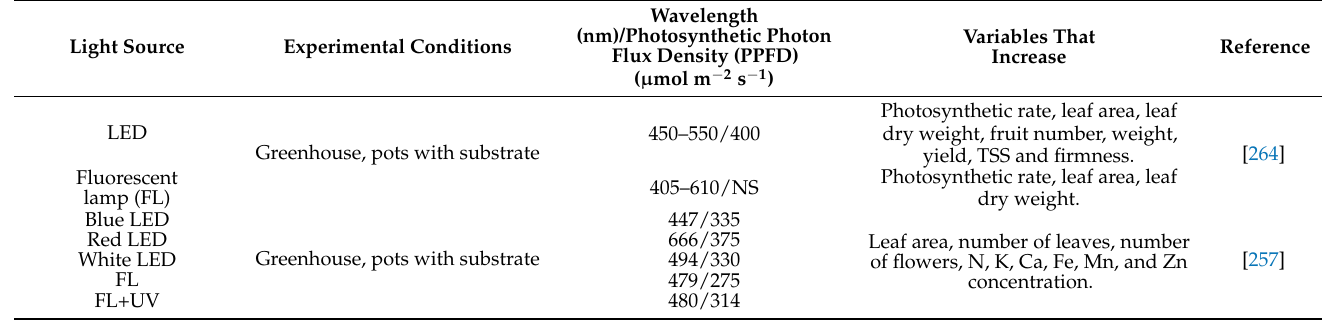
Table 11. Positive effects of UV and visible light supplementation on some growth or quality variables of strawberry